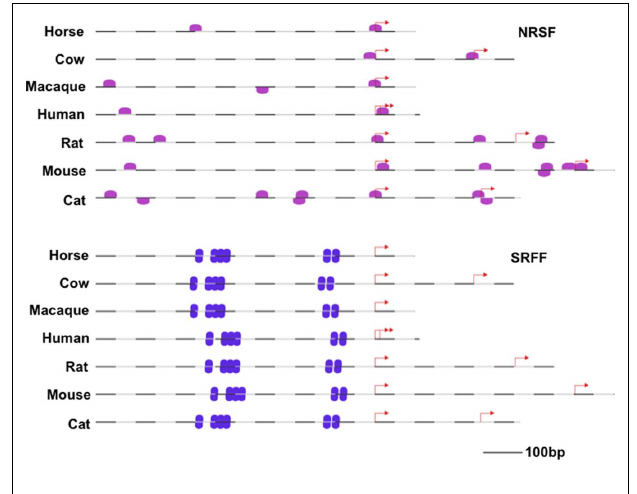
FIGURE 7 | Genomatix ™ -derived promoter alignments showing the position of predicted NRSF (upper, pink) and SRF (lower, purple) elements within seven mammalian promoters ( − 770 to + 100bp relative toTSS). Red arrows represent transcriptional start sites (NB. > 1 predicted in some species).